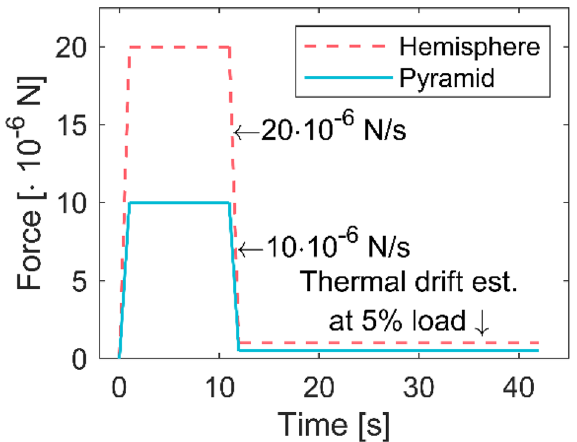
Figure 7. Load schedule of the AFM-NI experiments for the hemispherical and pyramidal